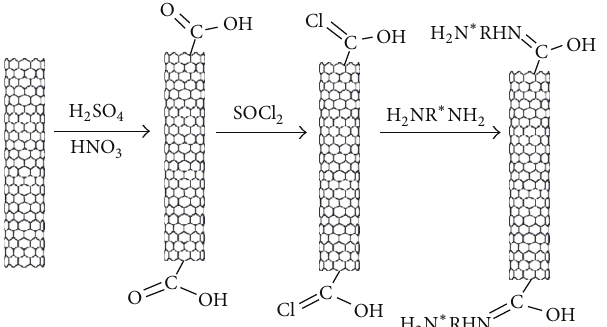
Scheme 7: The procedures used for functionalization of MWCNTs by Shen et al.